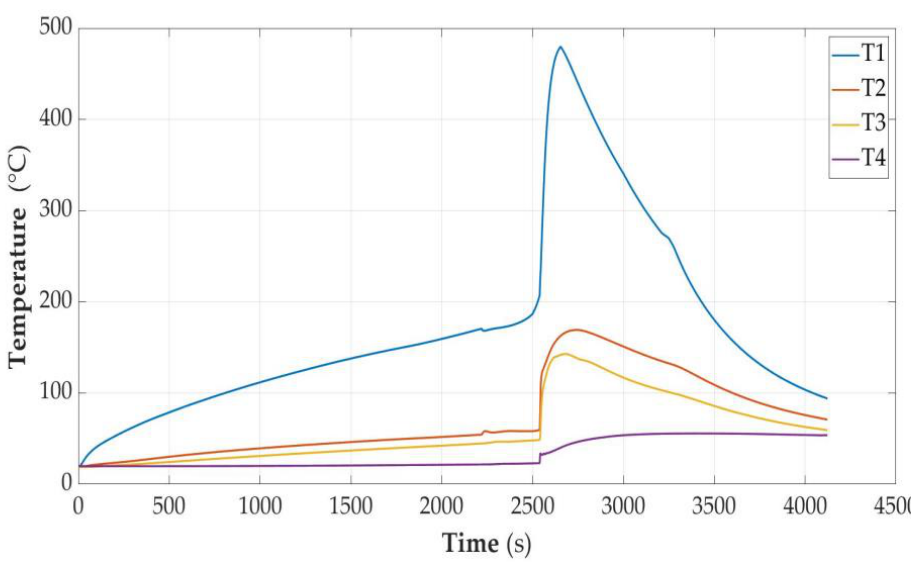
Figure 7. Graphs of temperature changes during heating and energy supplied to the cell module in the SOC = 50% state.